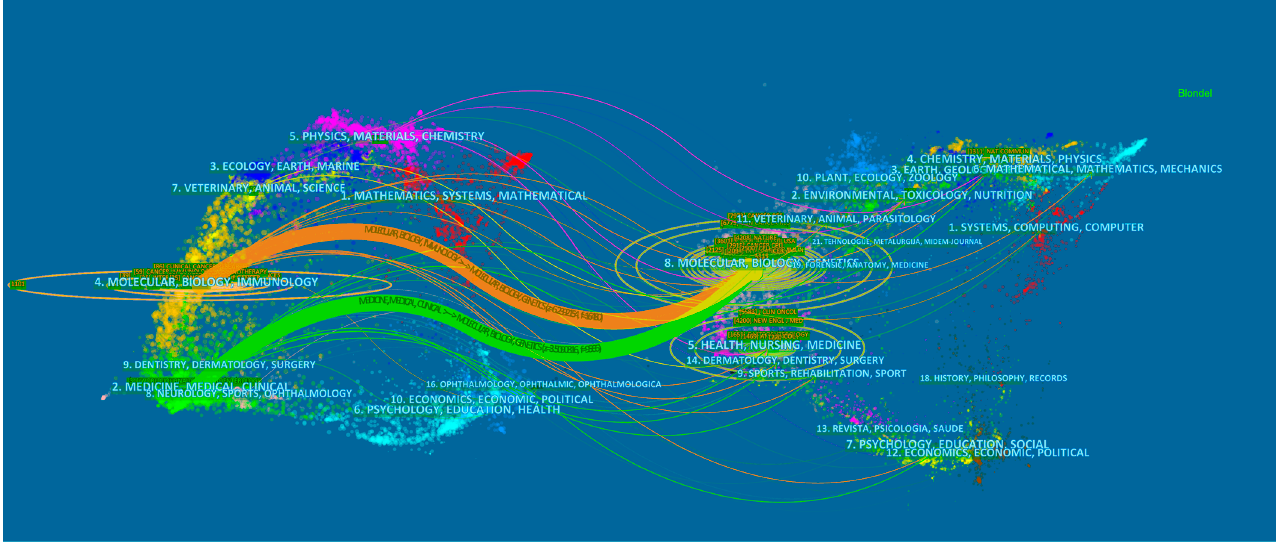
Figure 5. A dual-map overlap of journals on immunotherapy for pancreatic cancer completed by CiteSpace.